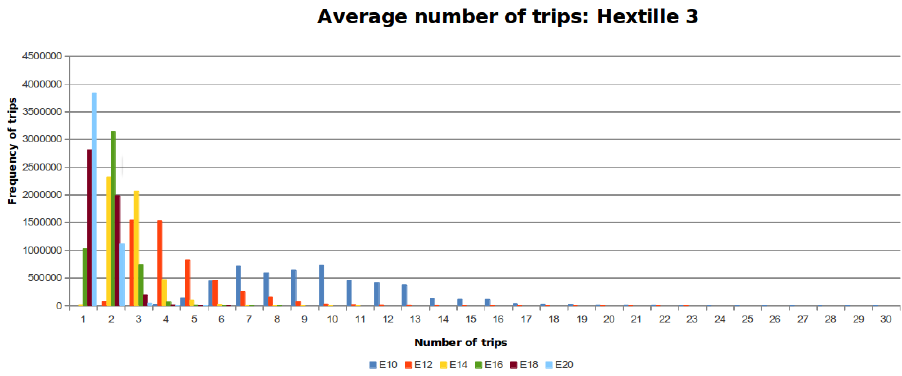
Figure 10. DFG G 3 with the variation of the required number of steps (cid:101) h for the 5,000,000 flights. The average number of trips for G 3 with (cid:101) h is 10 trips with a frequency between 500,000 and 1,000,000 flights to explore the whole DFG. If the number of steps is incremented, the average number of flights reduces.